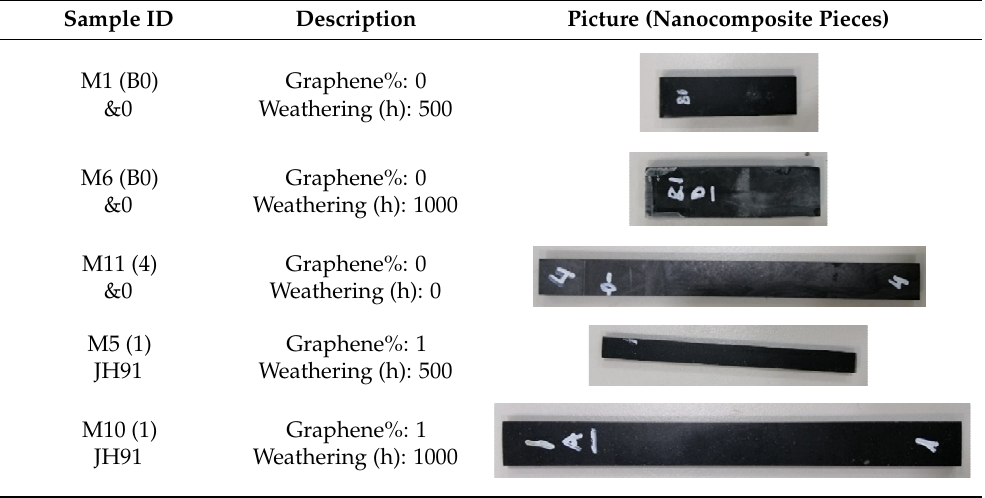
Table 2. List of graphene-polyester composite